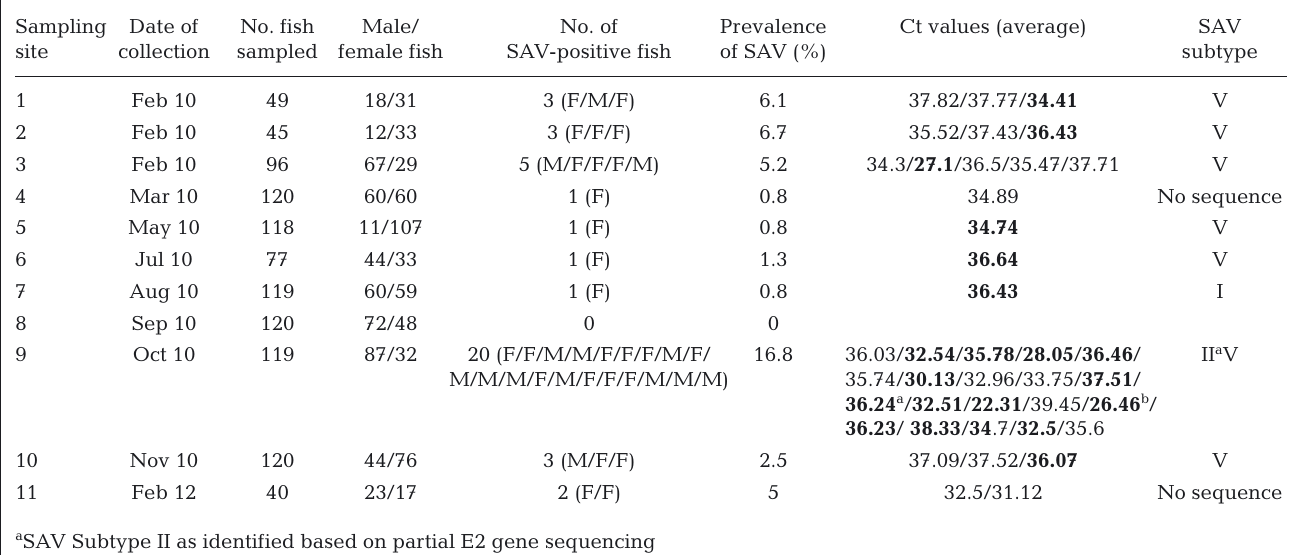
(Table 2). SAV nucleic acid variability among the individual study sites and within Site 9 was investi- gated, showing a 0.27 to 1.89% divergence in Sub- type V originating from dab (Fig. 2). No amino acid substitutions resulted from the observed variation in the analysed partial E2 region. Phylogenetic analyses using Bayesian, ML and NJ methods (Fig. 3) provided maximum statistical sup- port for monophyletic SAV Subtypes III and II, using nomenclature introduced by Fringuelli et al. (2008). Table 2. Prevalence of salmonid alphavirus (SAV), and summary information for common dab Limanda limanda . qPCR was conducted in triplicate, with positives only being considered if all 3 independent reactions showed a SAV target. Samples sequenced for the partial E2 gene are shown in bold . See Fig. 1 for the location of sampling sites. F: female; M: male (sex of SAV-positive fish is given in parentheses; Ct values for these individuals are given in the same